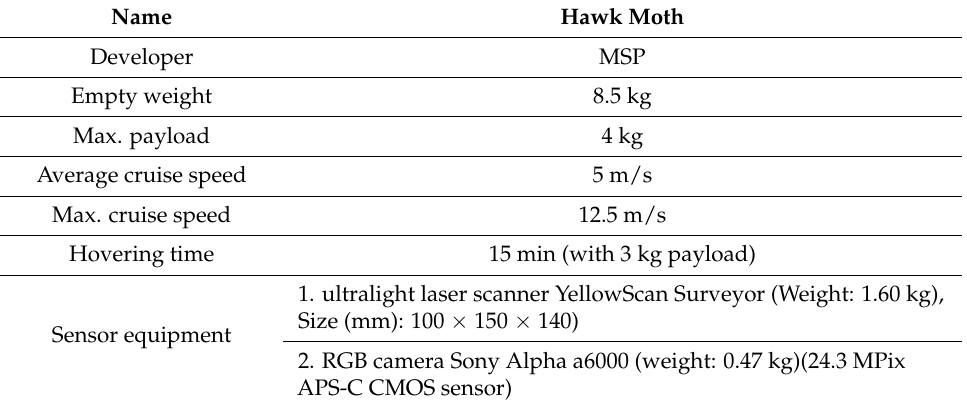
Table 1. Hawk Moth platform specification.